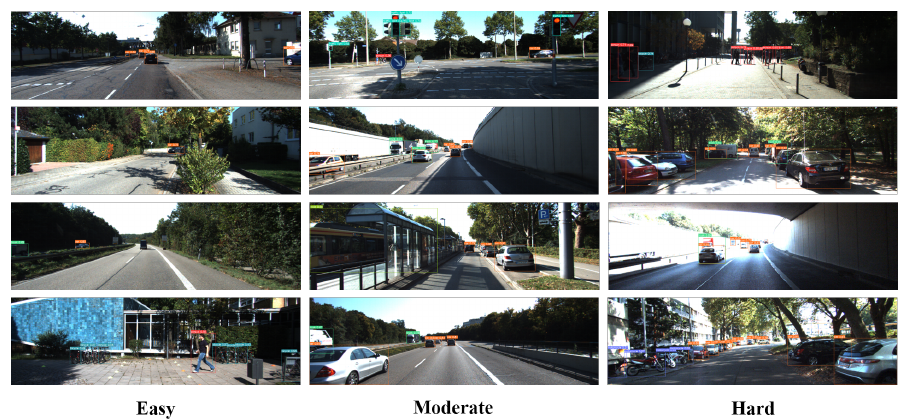
Figure 9. Visualization results on COCO2014.